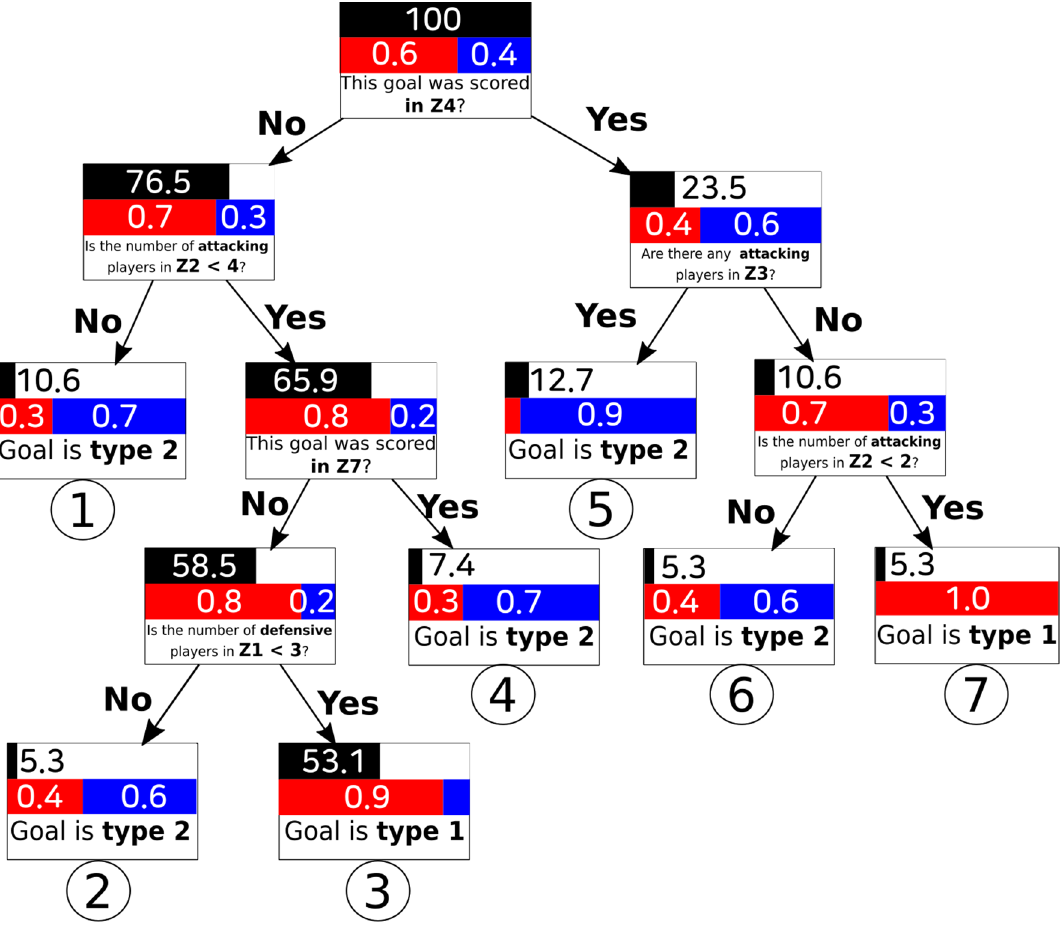
Figure 4. Final decision tree (Accuracy 0.83). Note on colours: black (% goal-scoring); probability of scored of different type goals: red (elaborate attacks) and blue (counterattacks).